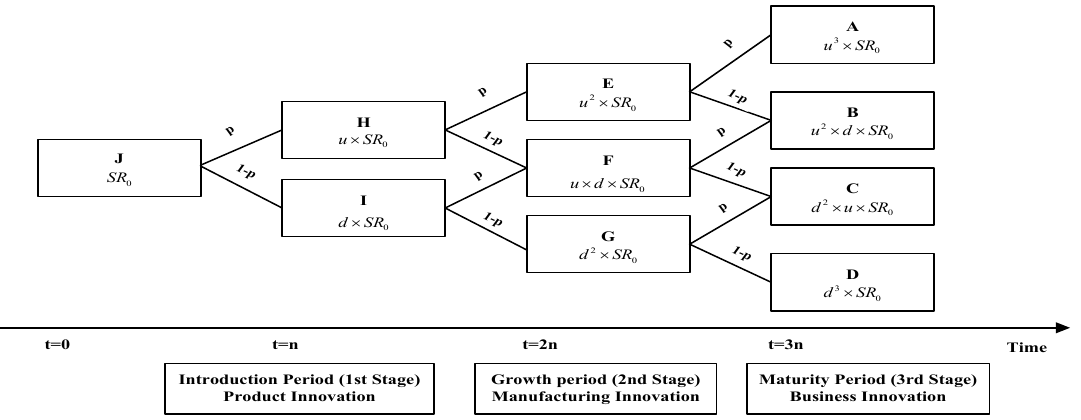
Figure 2. Revenue change path.